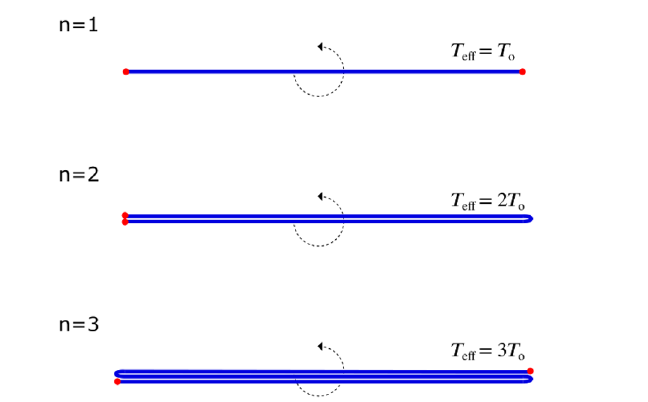
Figure 2 . The ordinary rotating string has no folds, but for ω = n π n − 1 folding points and effective tension nT o . For even n the endpoints of the string coincide in target